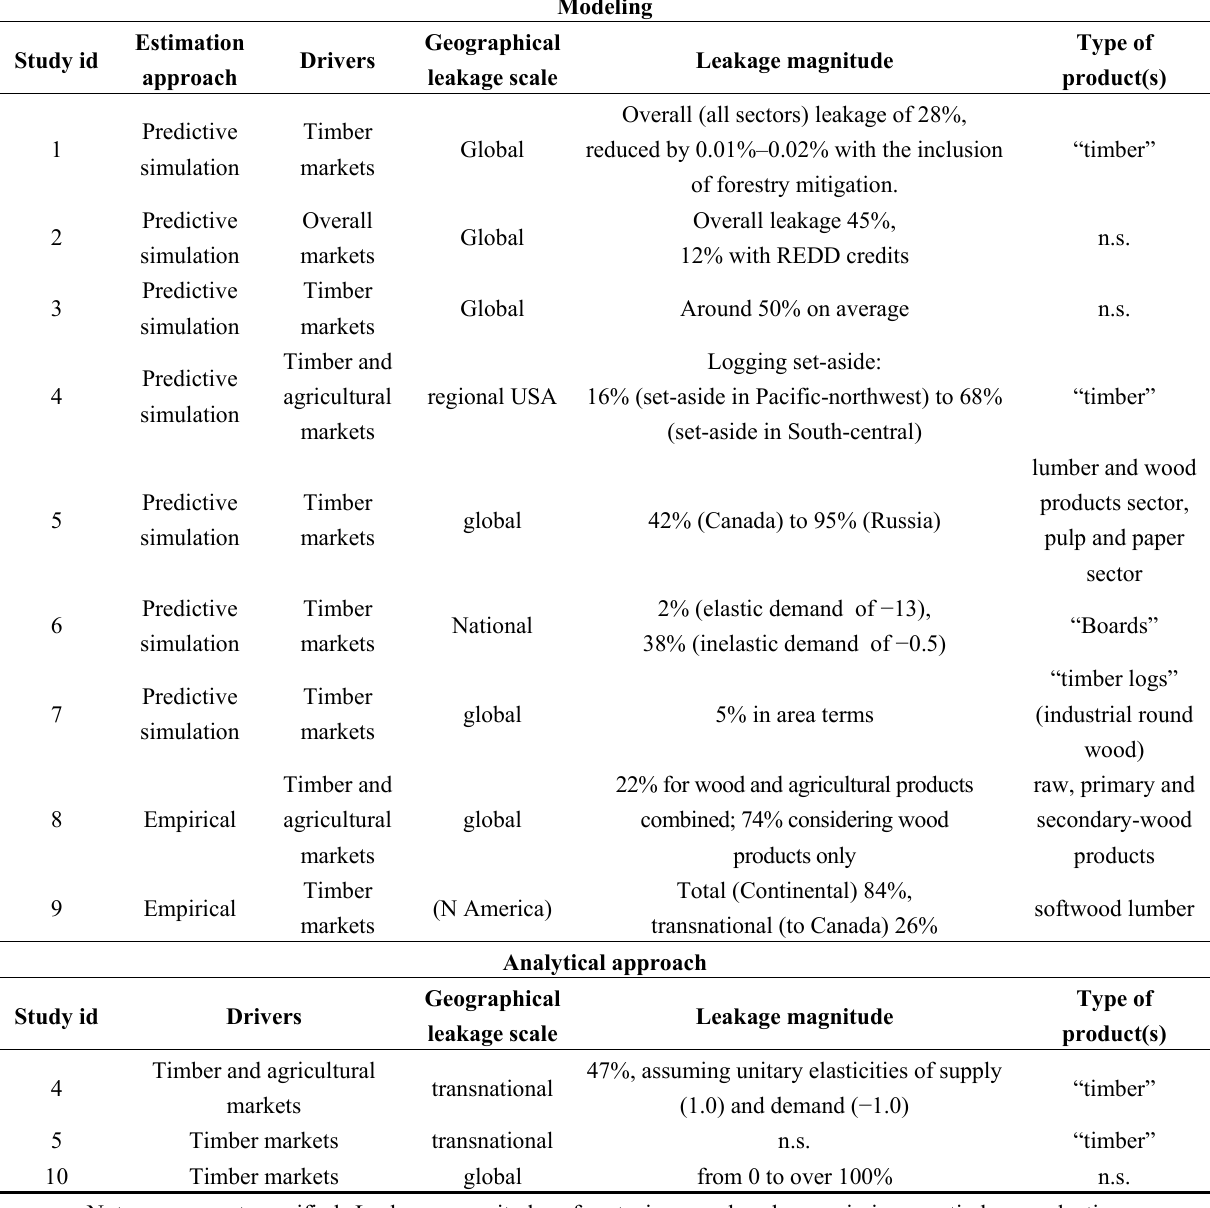
Table 1. Leakage drivers, magnitude and geographical